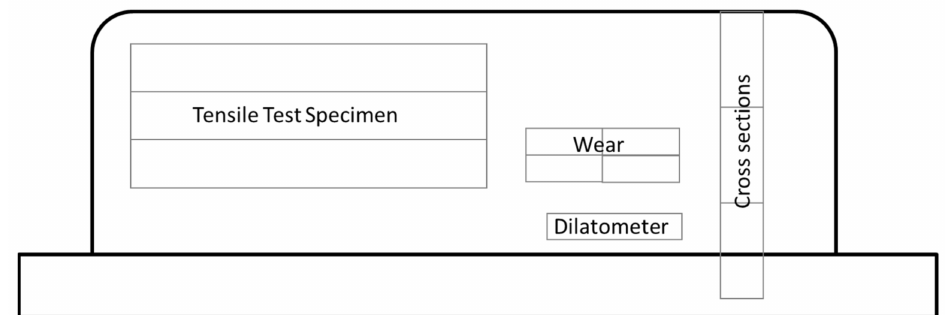
Figure 4. Positioning of the specimen in the deposited CCA wall-like structure.